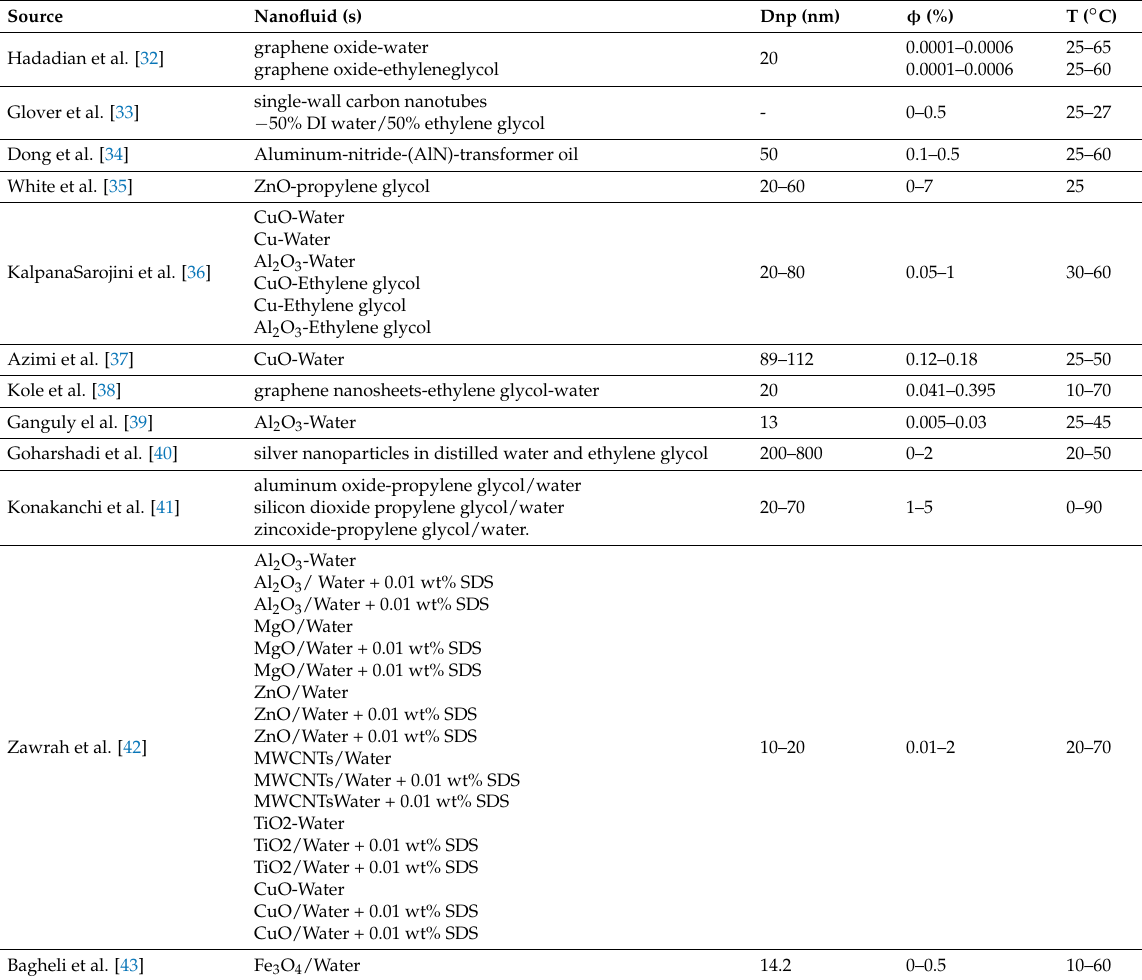
Table 3. Details of data bank used for developing the artificial neural network (ANN)